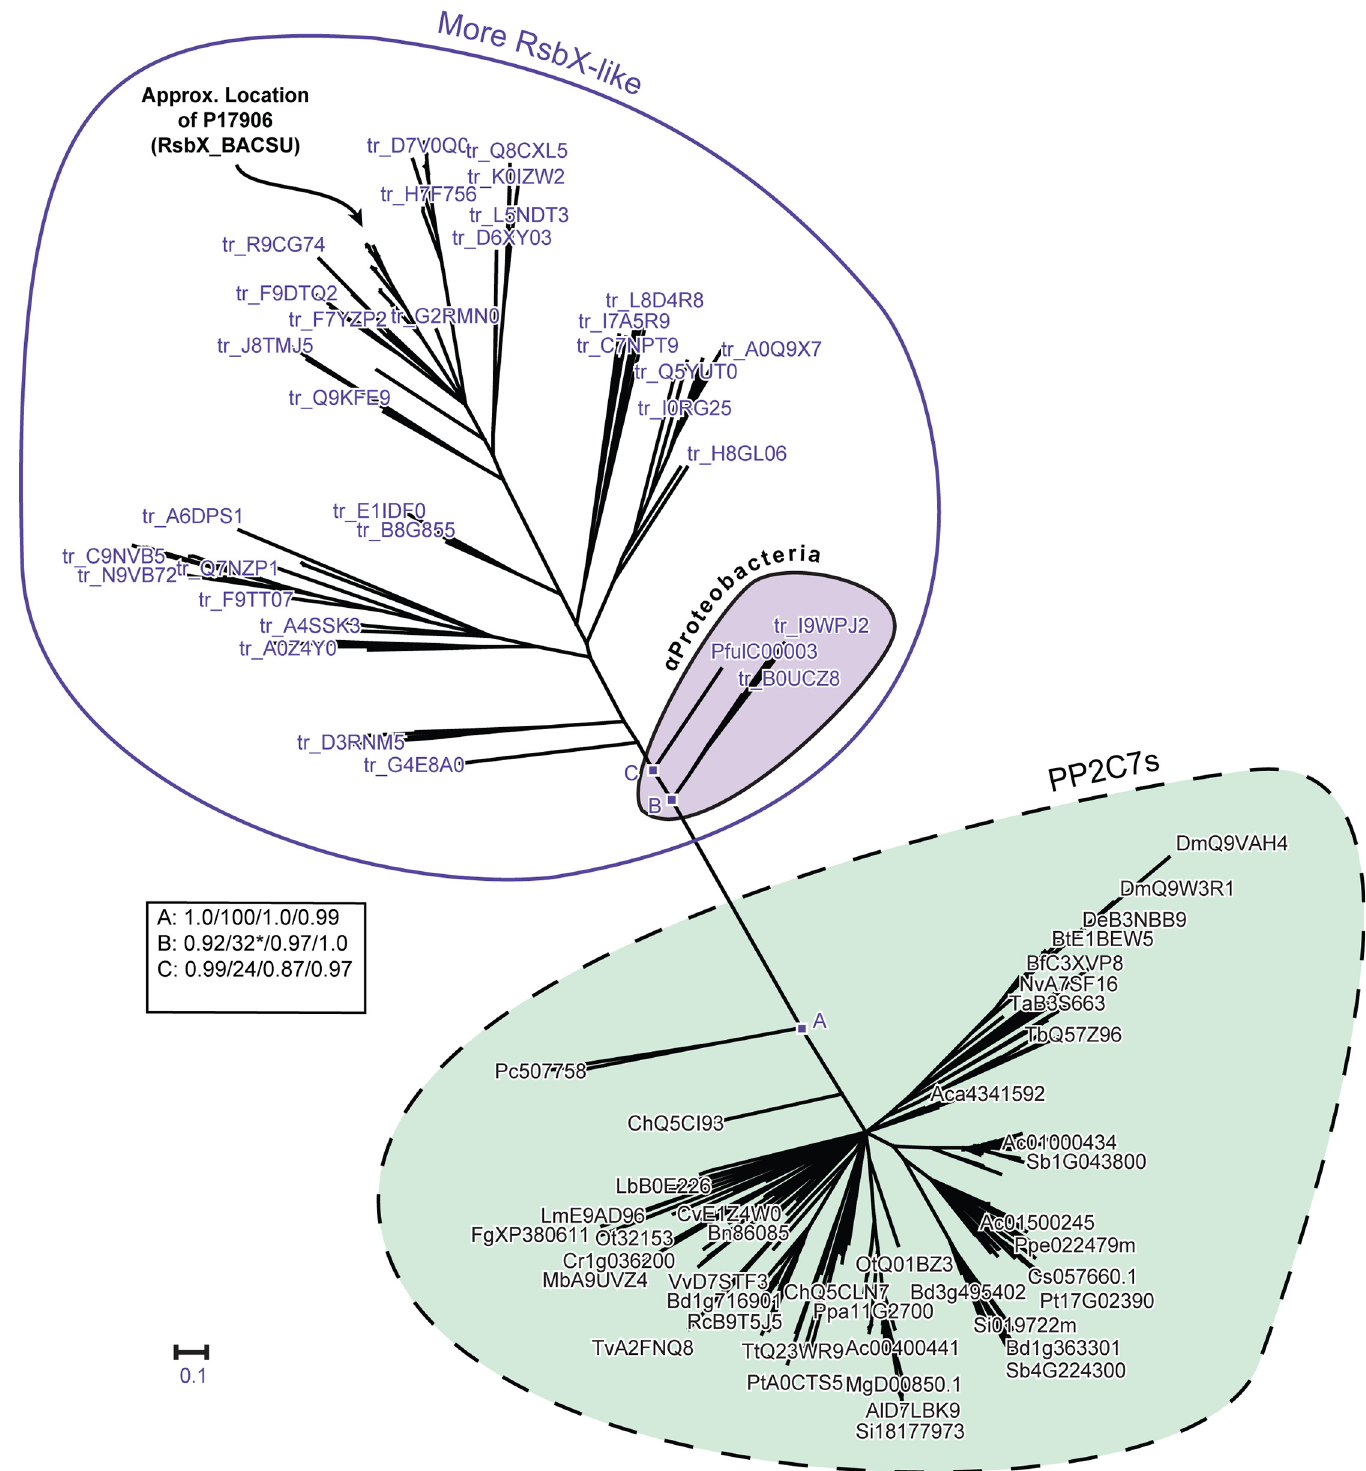
Fig 4. Phylogenetic radial tree depicting interrelationships between PP2C7 sequences and bacterial Group II PP2C sequences. The PP2C7 set is a very large and diverse one (238 sequences) and the bacterial Group II sequences are of the “ GN ” type, from the “ More RsbX-Like ” assemblage (144 sequences) (sequence varieties described in the text). For this analysis the sequences of the Myxococcales group have been removed (A9GSF9, A6FYN9, A9GWA1, E3FWN8, L7U8R0) (see text for rationale). Inference of unrooted phylogenetic trees was performed as outlined in “ Materials and Methods. ” The